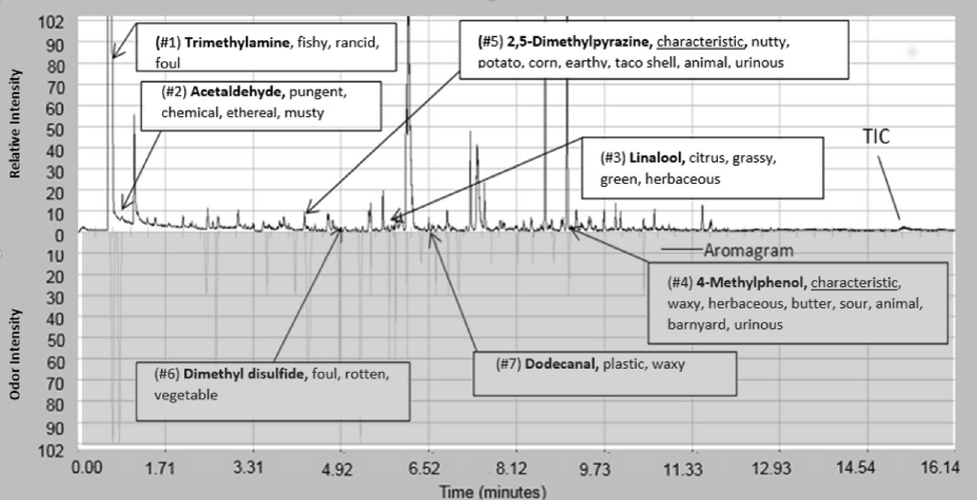
Figure 3. Simultaneous chemical and sensory analyses of compounds and scents in lion MF headspace. Top seven most odorous compounds in lion marking fluid based on measured odor intensity. Chromatogram (top) highlighting identified compounds in lion MF do not necessarily follow their measured odor intensity (aromagram, bottom). The odor character descriptions are based on panelists’ evaluations. Aromagram was created by panelists during sensory analyses, recording odor character, intensity and start-end detection times.